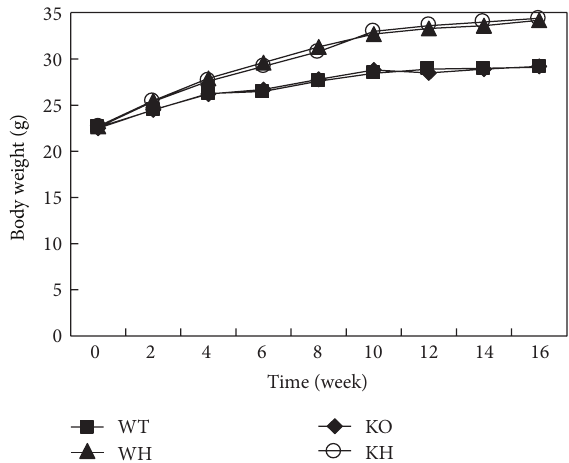
Figure 1: The curve of body weight. WT: wildtype mice; WH: wildtype mice with high-fat diet; KO: ACE2 knockout mice; KH: ACE2 KO mice with high-fat